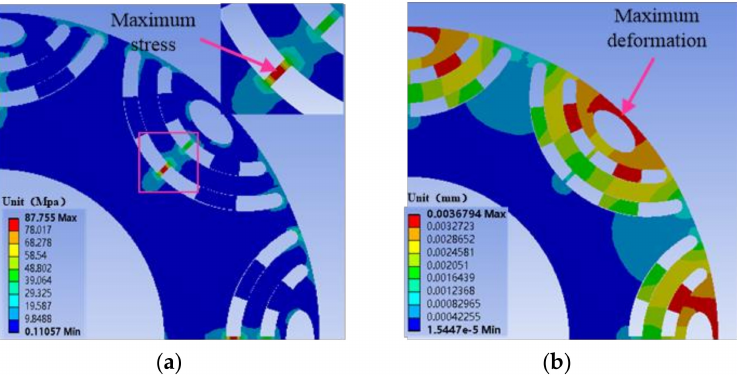
Figure2. Rotormechanicalpropertiesattherotorspeedof10000rpm: ( a )stressanalysis; ( b )deformation